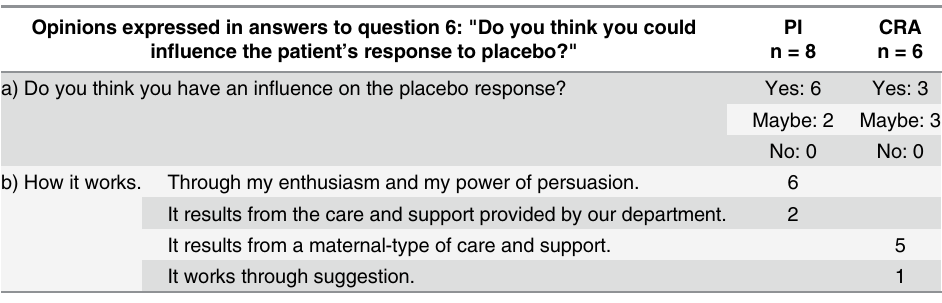
Table 5. General influence of PI and CRA on placebo response.